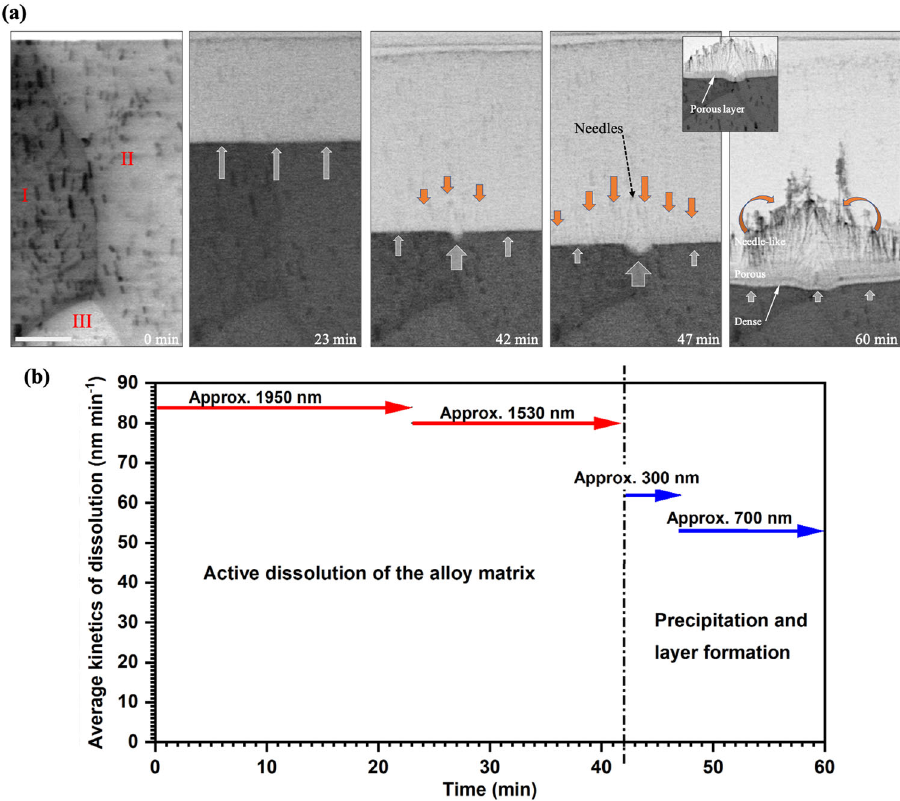
Fig. 2 Cross-sectional liquid-phase STEM observations of the conversion layer formation in 0.01 M NaCl + 0.01 M Li 2 CO 3 . a Time-resolved BF-STEM images of the conversion layer at different stages of the formation at the bare side of a sandwiched lamella. The image taken at 0 min is in the absence of the electrolyte, revealing three grains in the specimen. The process begins by uniformly dissolving the alloy until needles appear at the solution/alloy interface. A mature conversion layer including the columnar and porous layer is observed after 60 min. The inset is a closer look at the conversion layer taken at 55 min. The white and orange arrows indicate the dissolution and precipitation process, respectively. The specimen is approximately 400 nm thin excluding the TEOS layers. The scale bar is 1 μ m. b The graph presents the average kinetics of the alloy matrix dissolution at different stages of the conversion